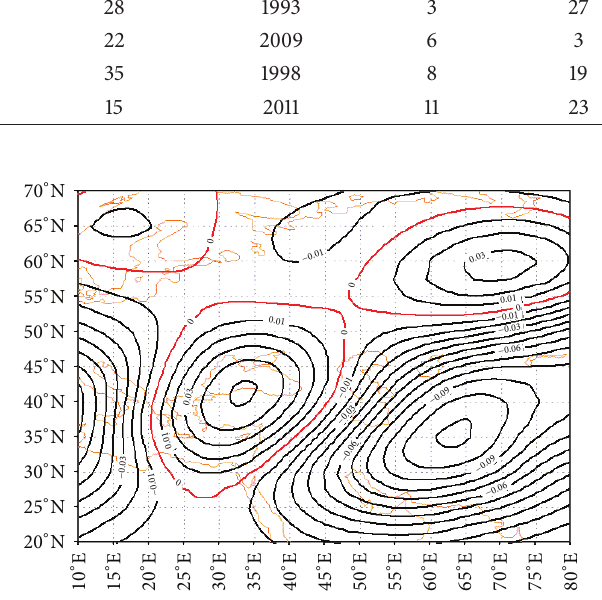
Figure 25: The eighth component of 500 HPa geopotential height level